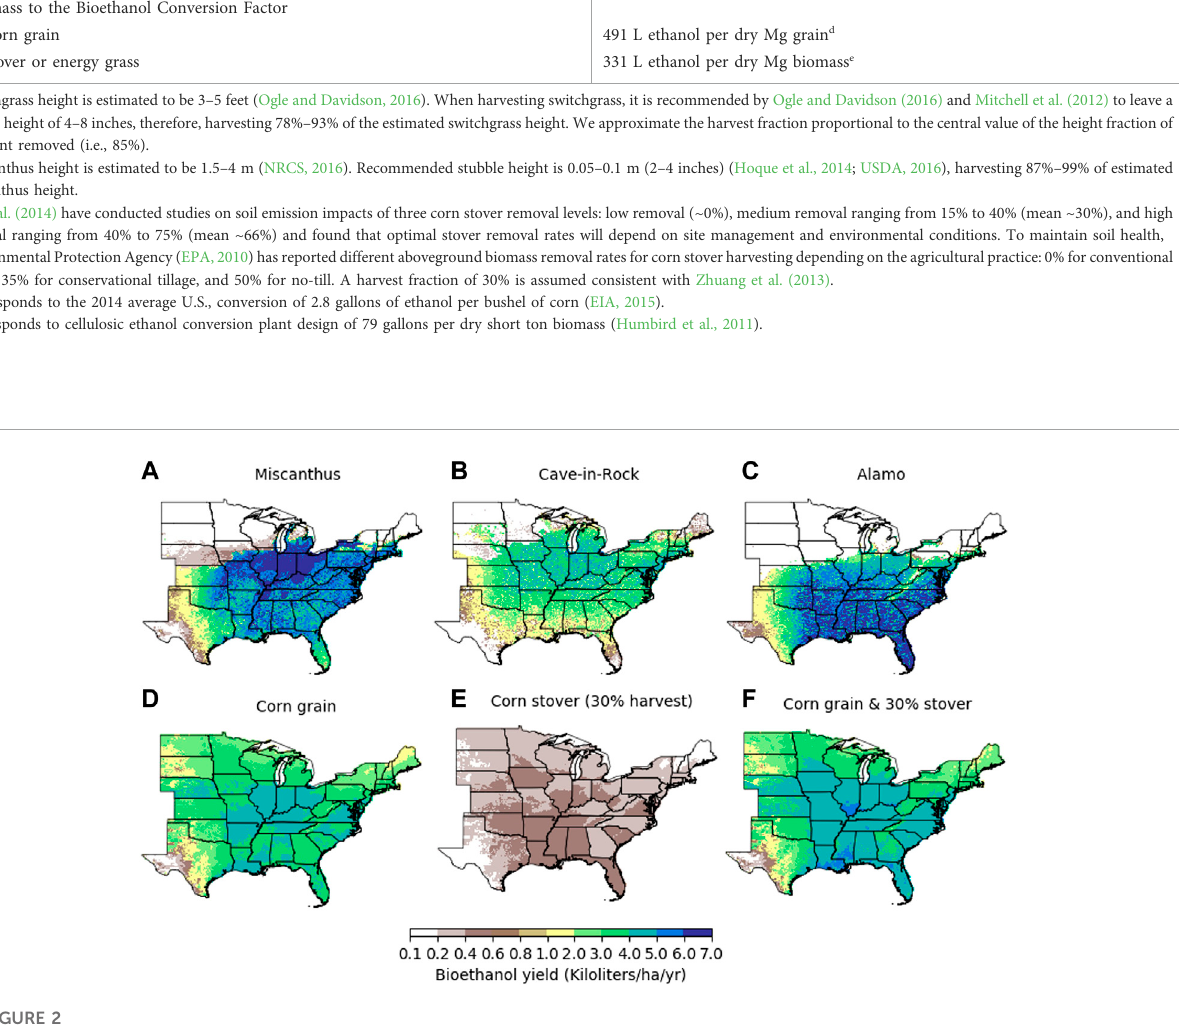
FIGURE 2 The distribution of potential annual bioethanol yield for Miscanthus (A) , Cave-in-Rock (B) , Alamo (C) , corn grain (D) , corn stover (E) , and corn grain plus 30% stover (F) . Irrigation is applied for corn in areas equipped for irrigation but not for bioenergy